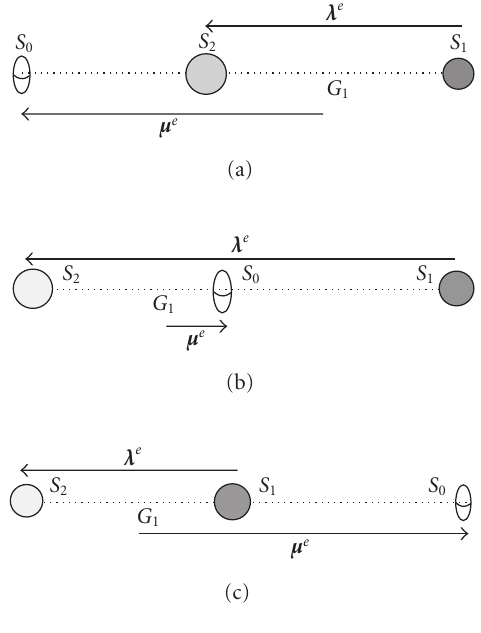
Figure 3.1. Eulerian